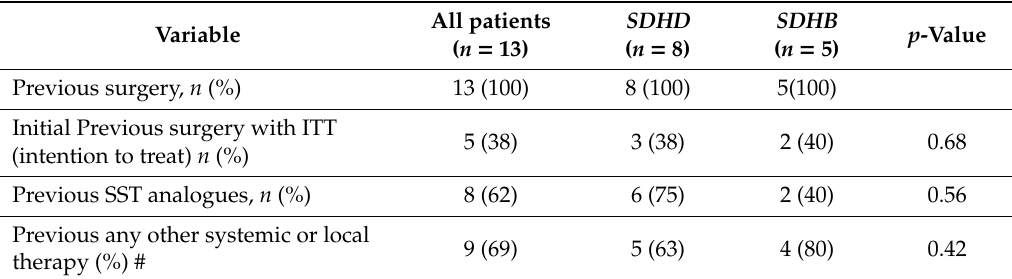
Table 3. History of previous treatment for the overall group and subgroups of patients with SDHD and SDHB mutations.